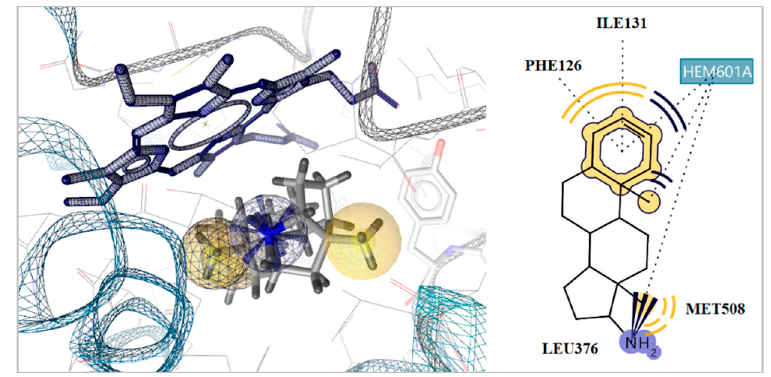
Figure 4. Docked conformation of the compound 19 in lanosterol 14 α -demethylase of C . albicans .